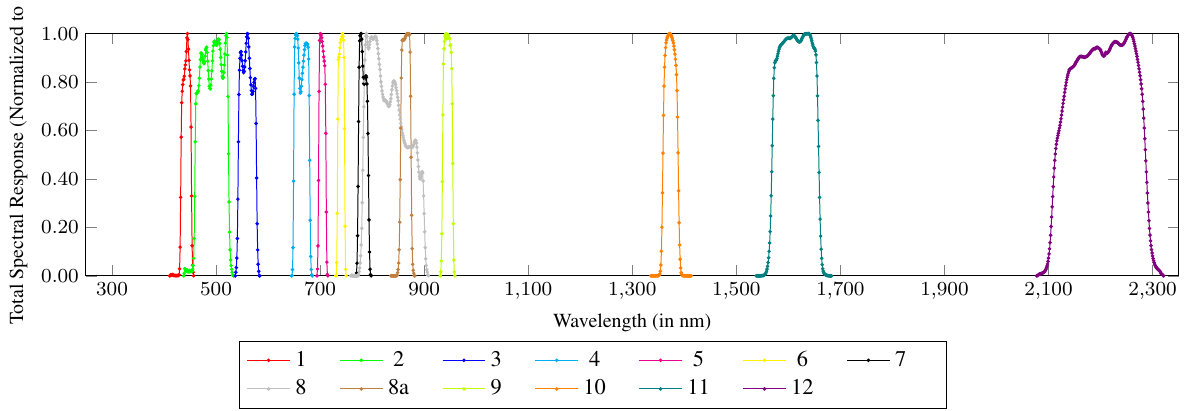
Figure 1. Visualization of the Sentinel-2 Spectral Response Functions (S2-SRFs), i.e. the measured spectral responses for each band of the Sentinel-2 MultiSpectral Instrument (MSI).